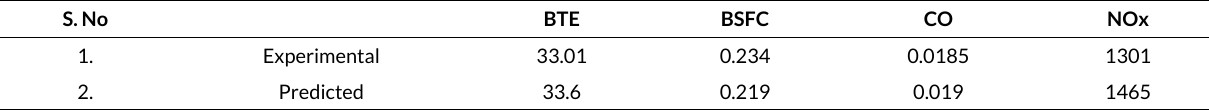
TABLE 9. CONFIRMATION EXPERIMENTAL